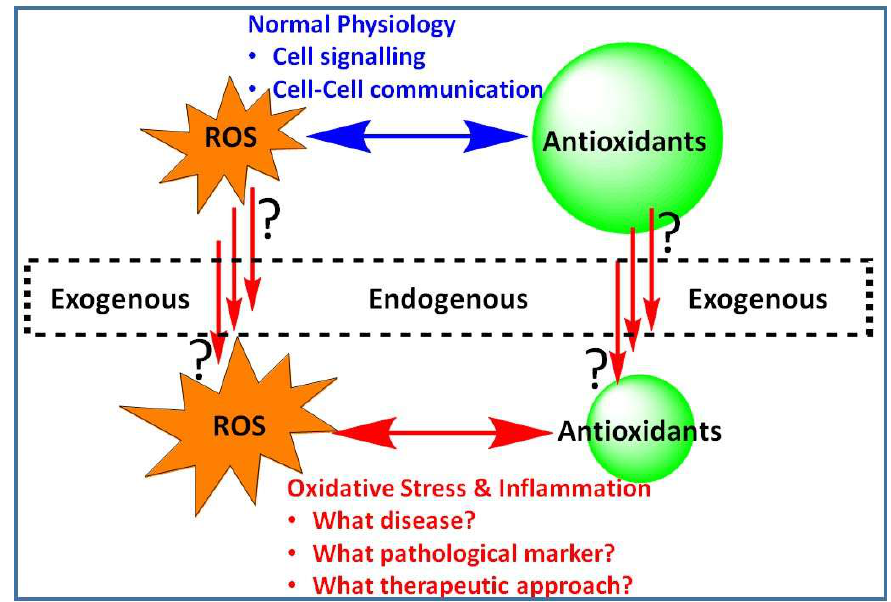
Figure 1. Reactive oxygen species (ROS) in health and disease. Generated under normal physiological conditions, ROS are vital to the normal functioning of cellular systems. Excessive level of ROS either from endogenous or exogenous sources; or that through increased level of their production or diminished antioxidant defences result in the development of oxidative stress (OS). This special issue focus on pathologies associated with OS and the interlinking inflammatory pathway with particular emphasis on disease markers and therapeutic intervention